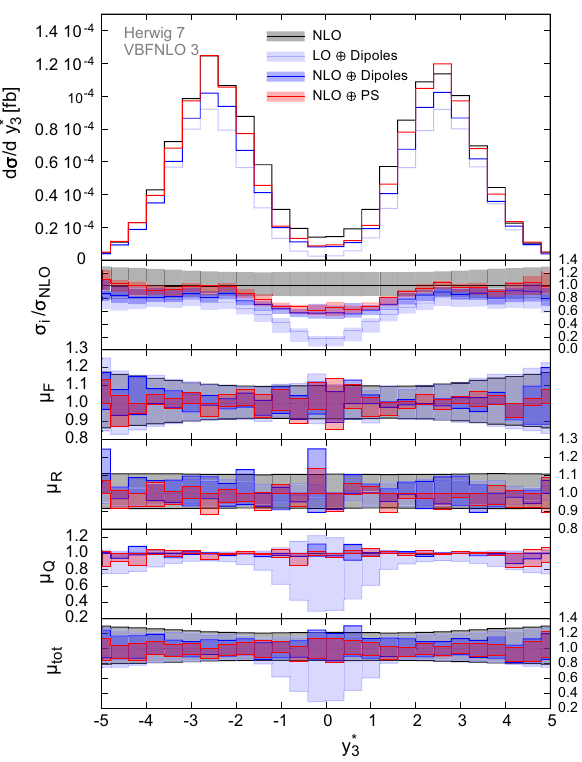
Fig. 8 The relative rapidity of the third leading jet with respect to the tagging jets. See Fig. 3 and the text for more details